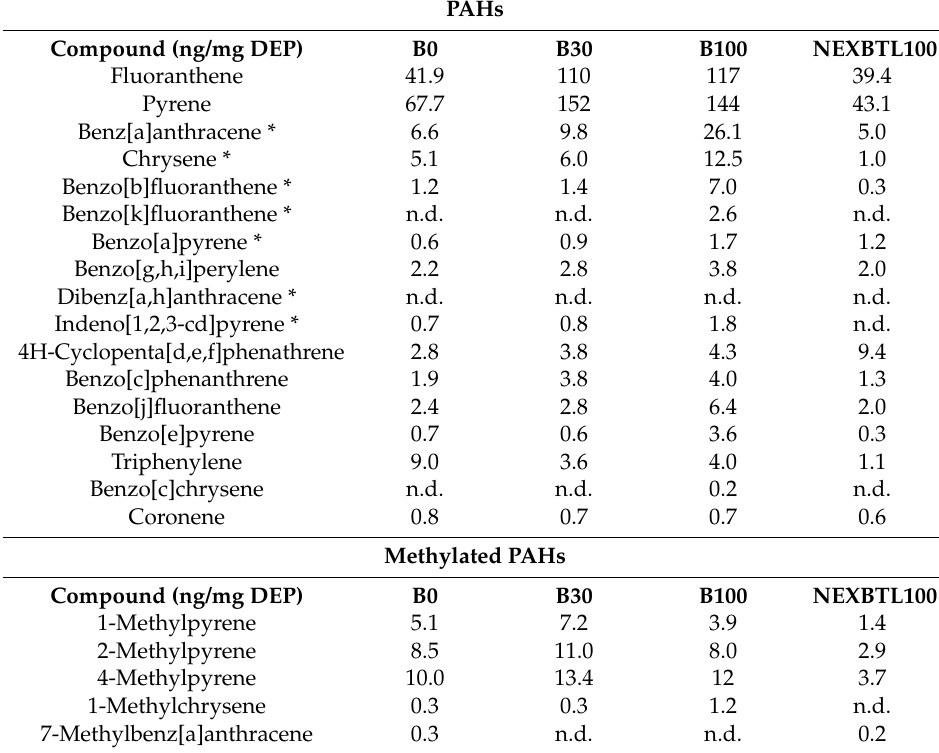
Figure 1. Characterization of collected particles: ( A ) number of particles per second as a function of their size (nm) for undiluted emissions from the tested fuels; and ( B ) the amount of particles (mg) per kg of individual fuels (average mass collected over 10 runs of WHTC cycle, see Materials and Methods). DEP, diesel exhaust particles. Table 1. Results of chemical analysis.